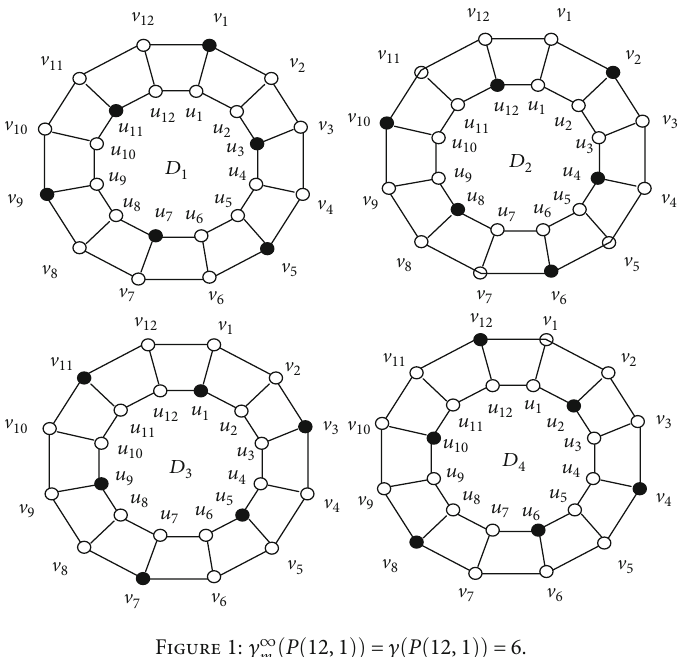
P ð 12, 1 ÞÞ = γ ð P ð 12, 1 ÞÞ = 6 . Figure 1: γ ∞ m ð